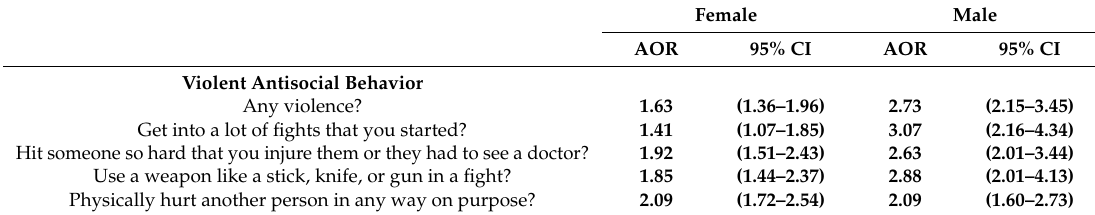
Table 3. Interpersonal violence among individuals who often experienced hunger during childhood, by